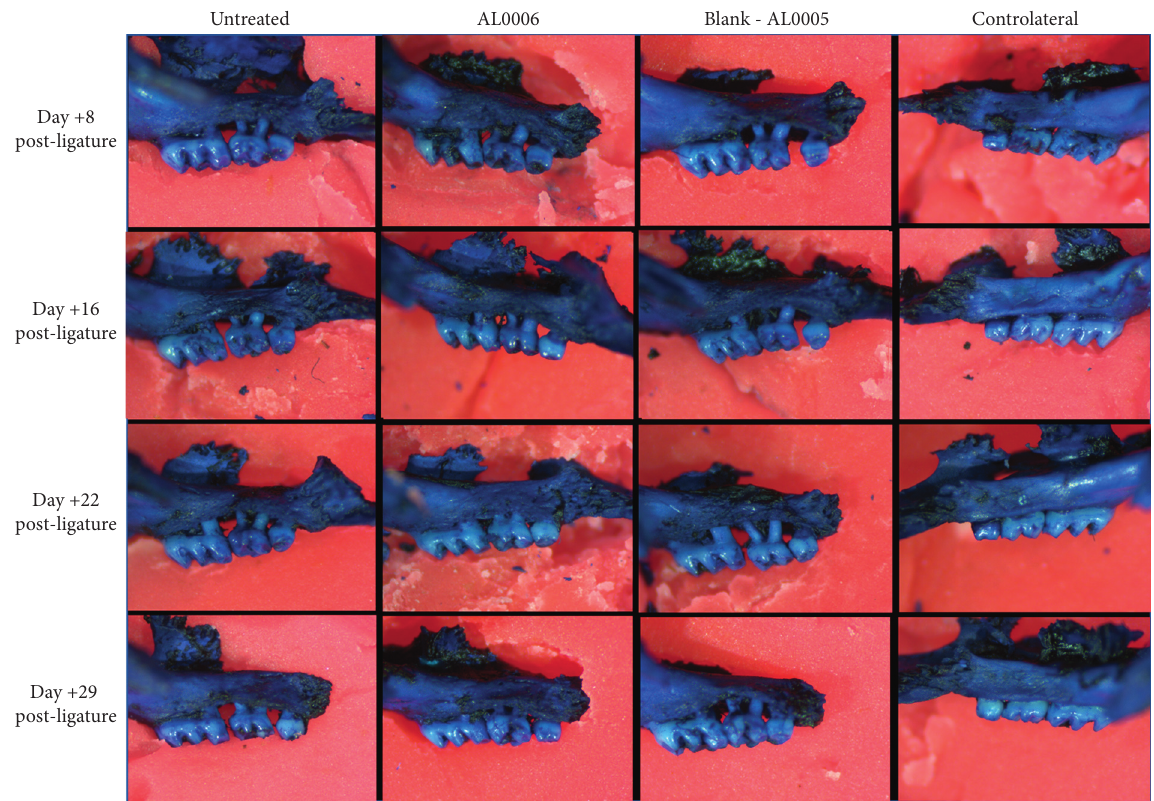
Figure 7: Representative images of maxillae, stained with eosin and methylene solution, at day +8, +16, +22, and